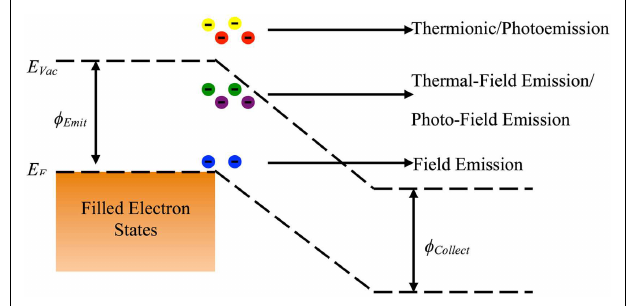
FIGURE 1 | Energy diagram for electron emission from metals